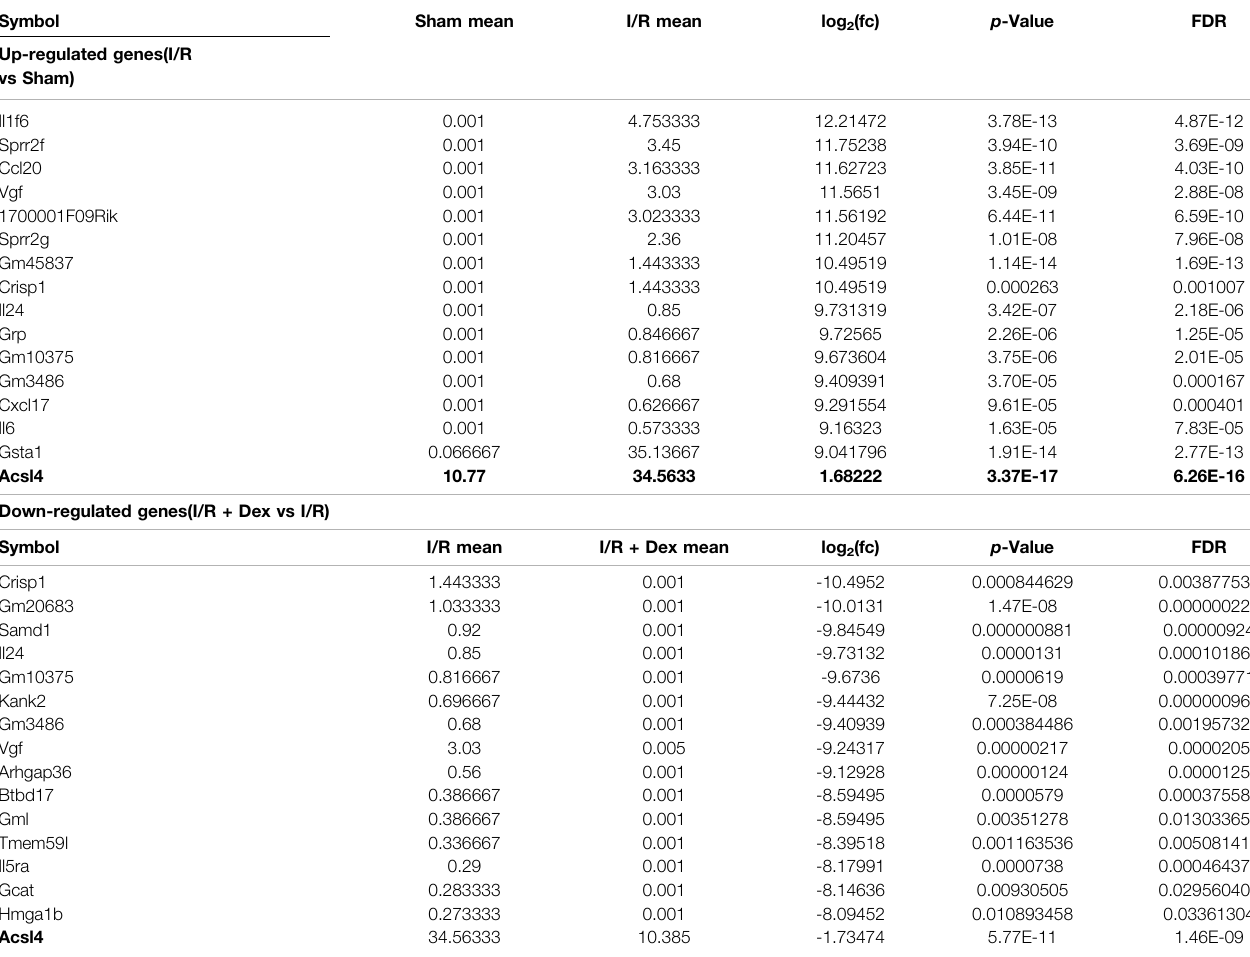
TABLE 1 | Top 15 up-regulated(Sham vs I/R)and down-regulated(I/R vs I/R + Dex)DEGs and ACSL4. Symbol Sham